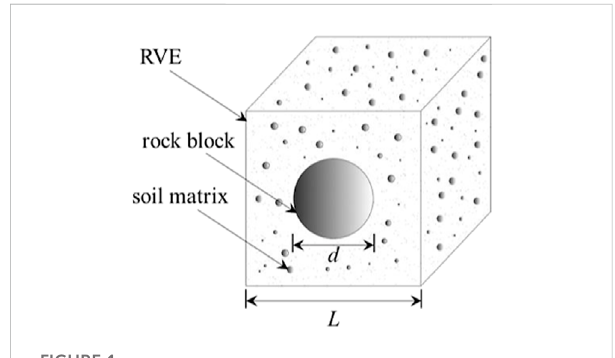
FIGURE 1 The representative volume element of soil-rock